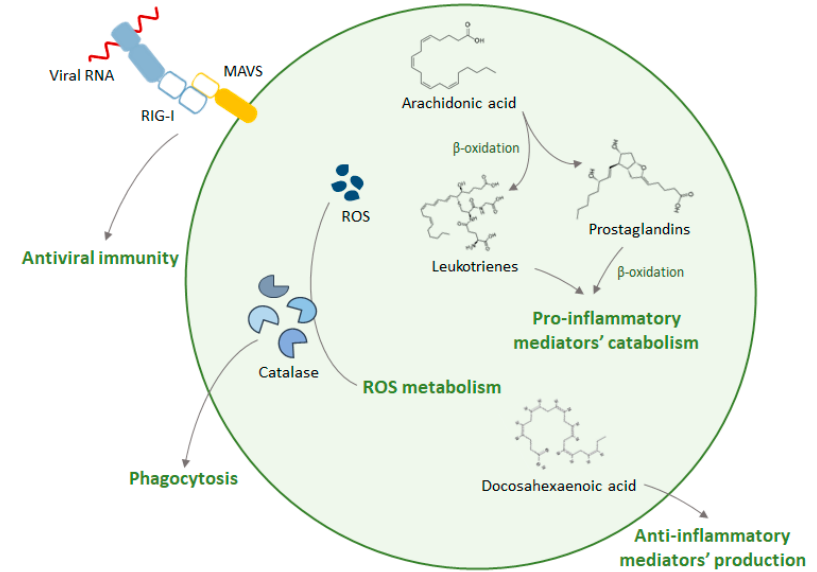
Figure 3. Schematic representation of the peroxisomal functions within innate immunity. Peroxisomes play an important role in antiviral defense through the RIG-I / MAVS-dependent signaling. Additionally, peroxisomes function as anti-inflammatory platforms as they metabolize and produce, respectively, proinflammatory and anti-inflammatory mediators. Moreover, peroxisomes discharge catalase into phagosomes, which is essential for reactive oxygen species (ROS) metabolism during inflammation.